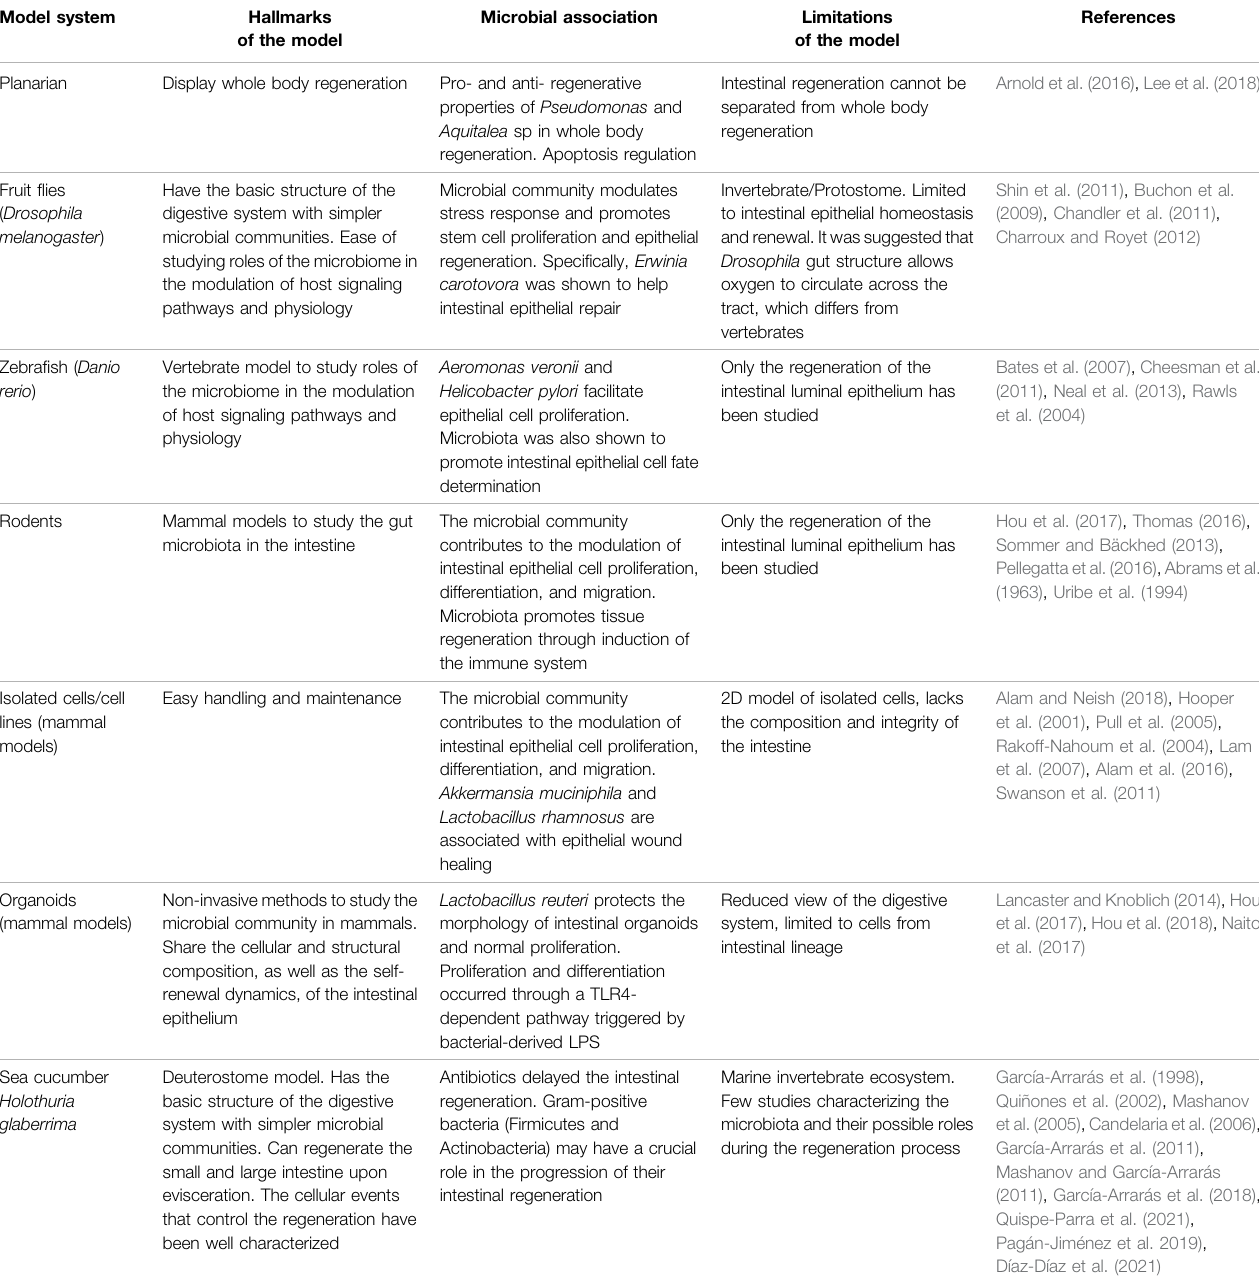
TABLE 1 | Model systems used to decipher the associations between the microbiota and the intestinal regeneration in biomedical research. Model